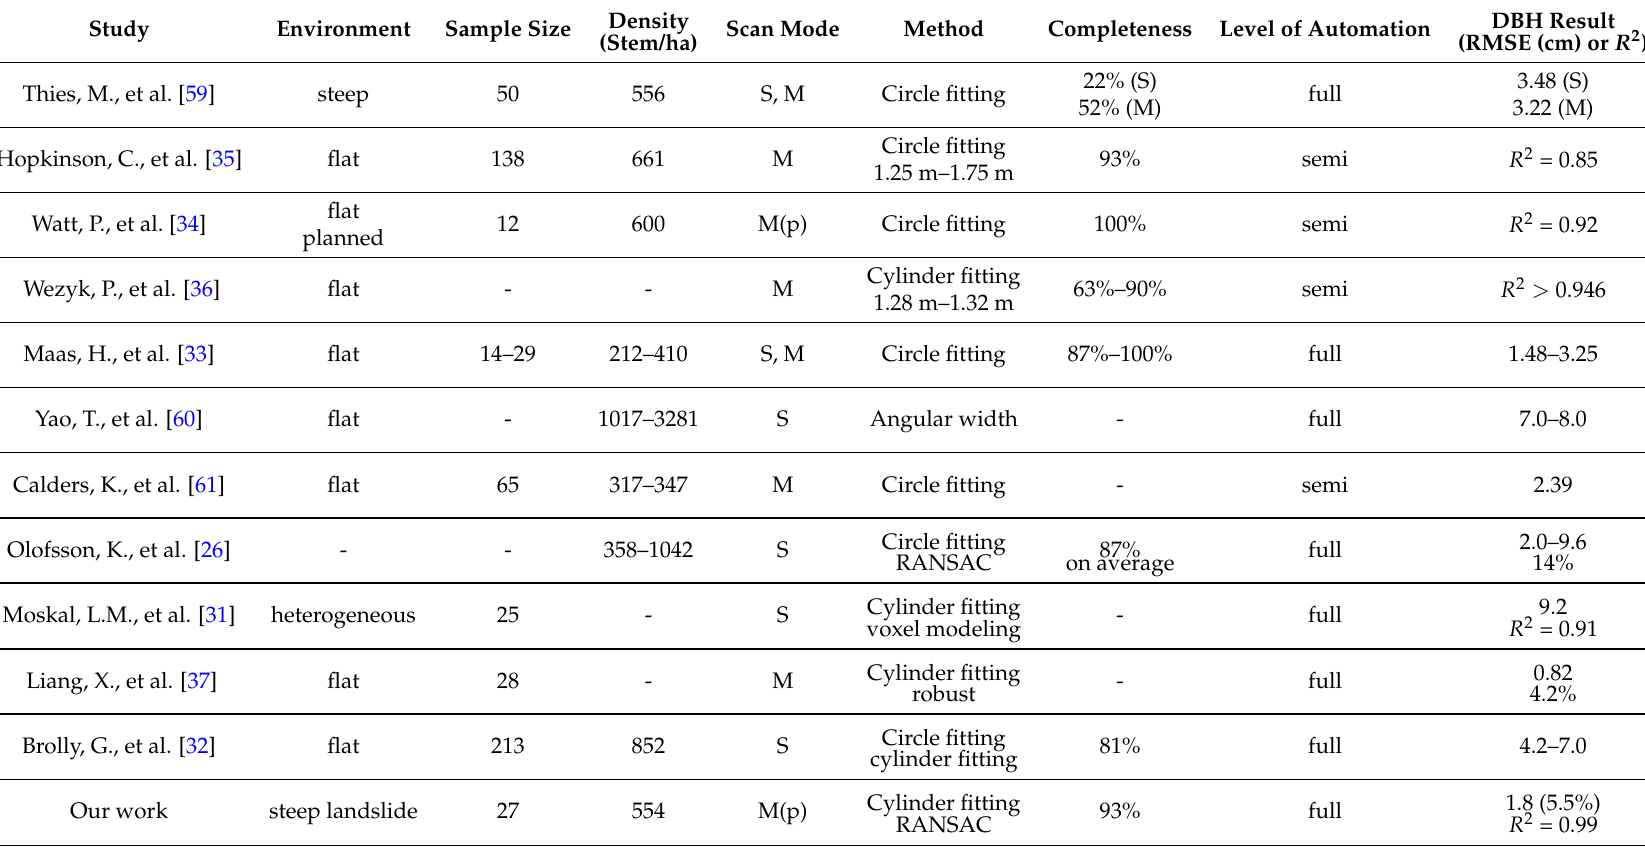
Table 4. Summary of several selected studies on automatic stem detection and modeling from TLS data. Only the first authors are shown to save space. Some of the contents and values are visually inspected or calculated from corresponding publications. S and M in scan mode stand for single scan and multiscan, respectively. M(p) means that multiscan is only performed